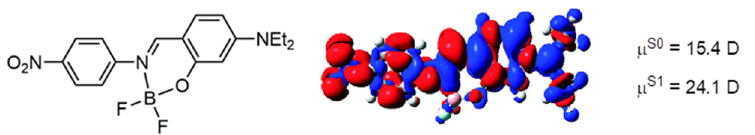
Figure 8. Representation of a typical boranil dye, with its electron density plots (EDD) and computed ground and excited state dipole moments. The level of theory used is PCM-M06-2X/6-31G (d). On the EDD plot, the blue and red lobes respectively represent regions of decrease and increase of electron density upon excitation. Adapted from Reference [60]. Copyright 2013 American Chemical Society.